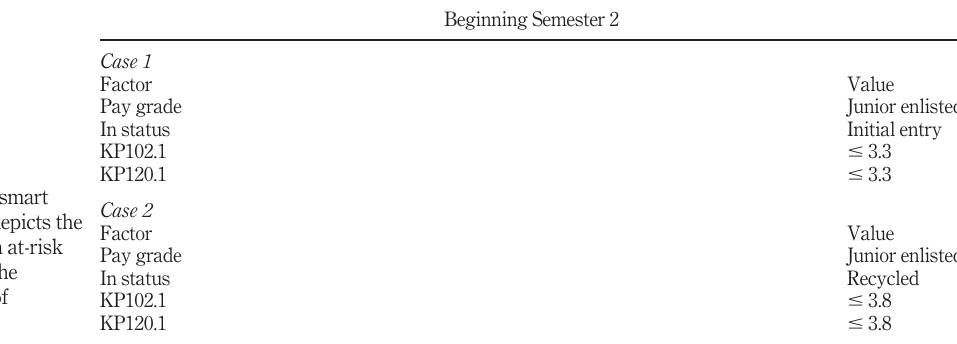
comparisons for all fi nal